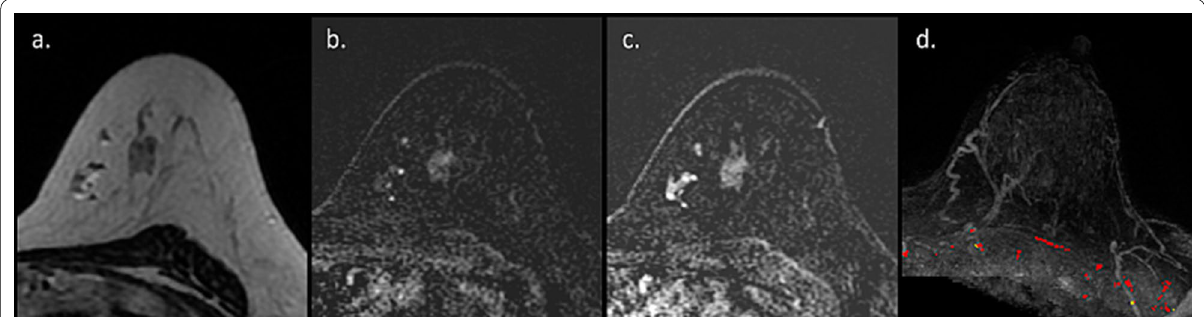
Fig. 5 MRI of lactating adenoma. MR images of patient presented with palpable mass on the left breast 2 months after breastfeeding cessation are presented. T2 weighted image showed a hypo‑intense mass ( a ), which exhibits a gradual enhancement and early and late DCE ( b , c ), below the signal intensity threshold for suspicious findings on CAD ( d ). Despite these benign features, the patient underwent vacuum‑assisted biopsy which revealed lactating